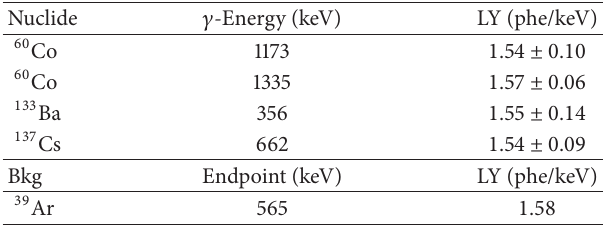
Table 2: Summary of light yield measurements from calibration lines (gamma sources) and background measurements,